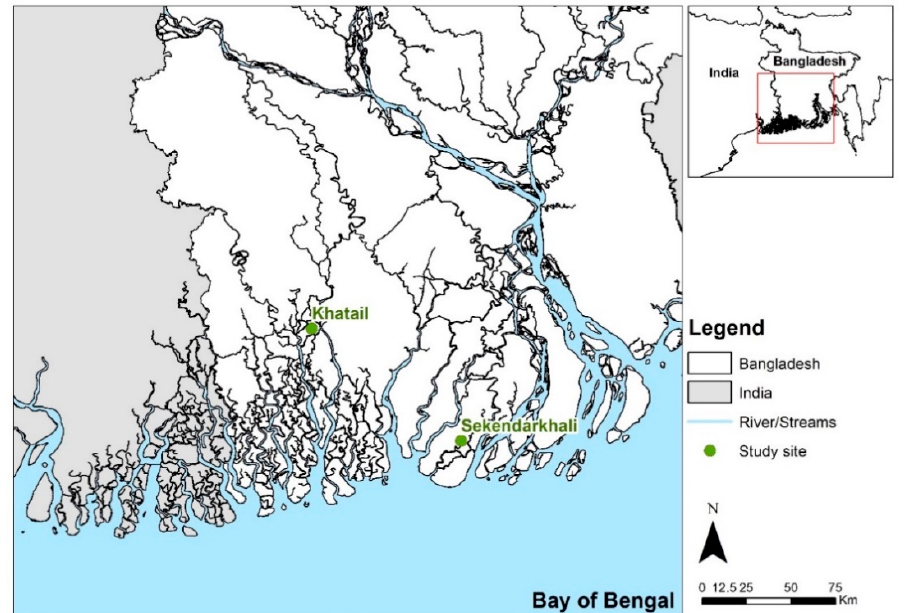
Figure 1. Location of the two case study villages, Sekendarkhali and Khatail, in southern Bangladesh.